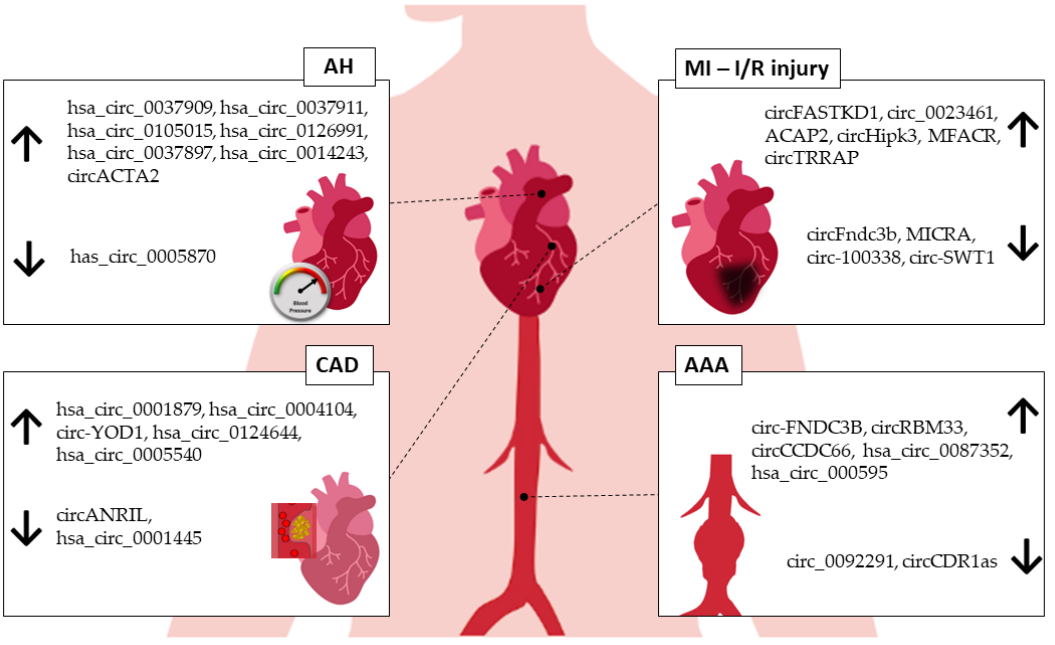
Figure 2. circRNAs associated with human CVDs. AH—arterial hypertension, MI—myocardial in- farction, I/R—ischemia/reperfusion injury, CAD—coronary artery disease, AAA—abdominal aortic aneurysm. ↑ —upregulated, ↓